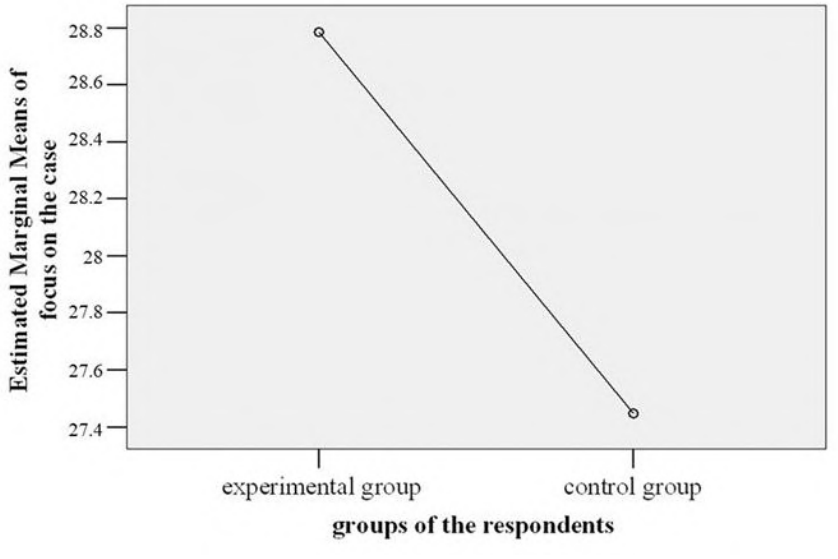
Figure 81: Presentation of paper